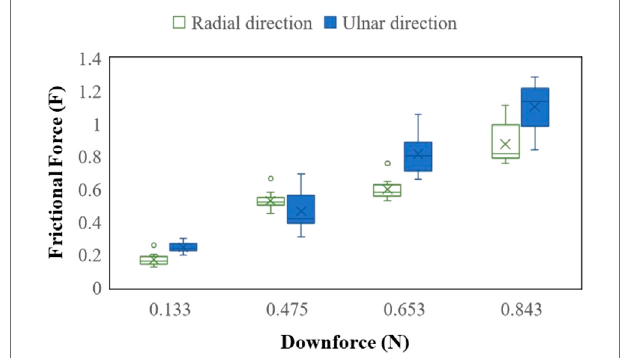
FIGURE 4 | Relationship between downforce and frictional force obtained by the results of force measurement in the case of sandpaper #100. The frictional force displayed direction-dependent difference.